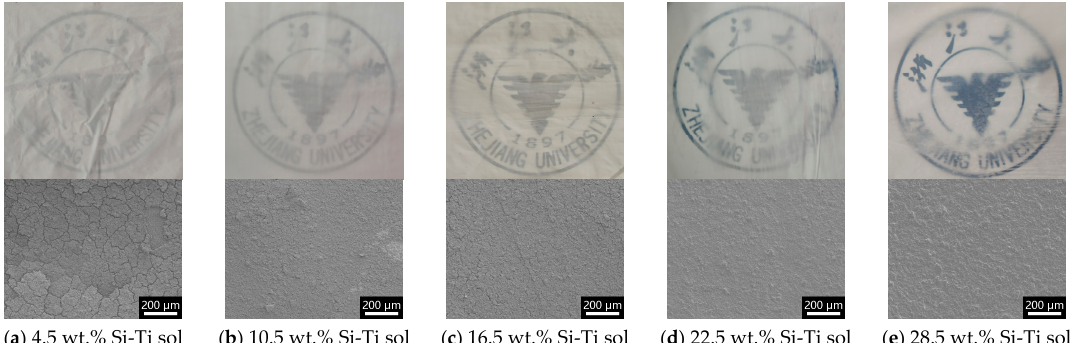
Figure 3. Digital photos and SEM images of the MSQ aerogel coating on ePTFE thin films with different Si-Ti sol contents. ( a ) 4.5 wt.%, ( b ) 10.5 wt.%, ( c ) 16.5 wt.%, ( d ) 22.5 wt.%, ( e ) 28.5 wt.%.